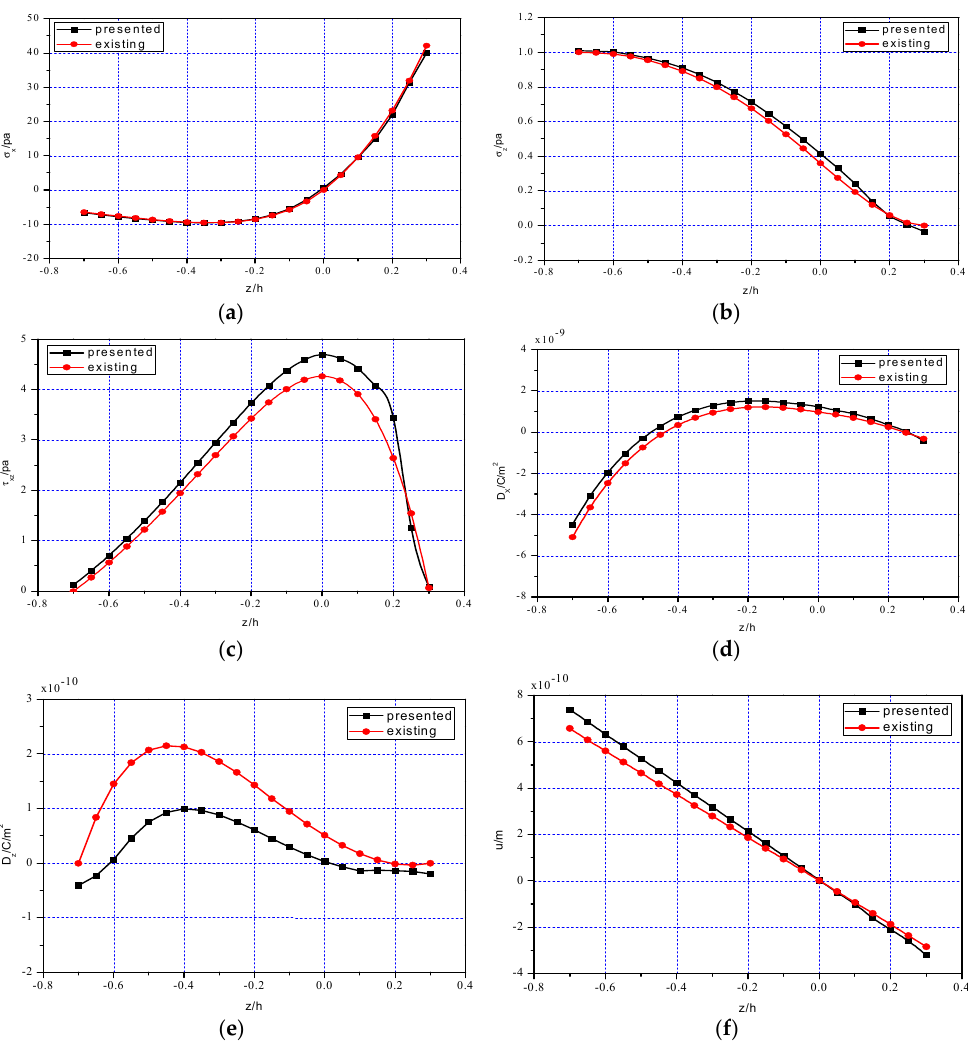
Figure 8. Comparisons of two-dimensional simulation presented in this study and existing solution from He et al. [27] at